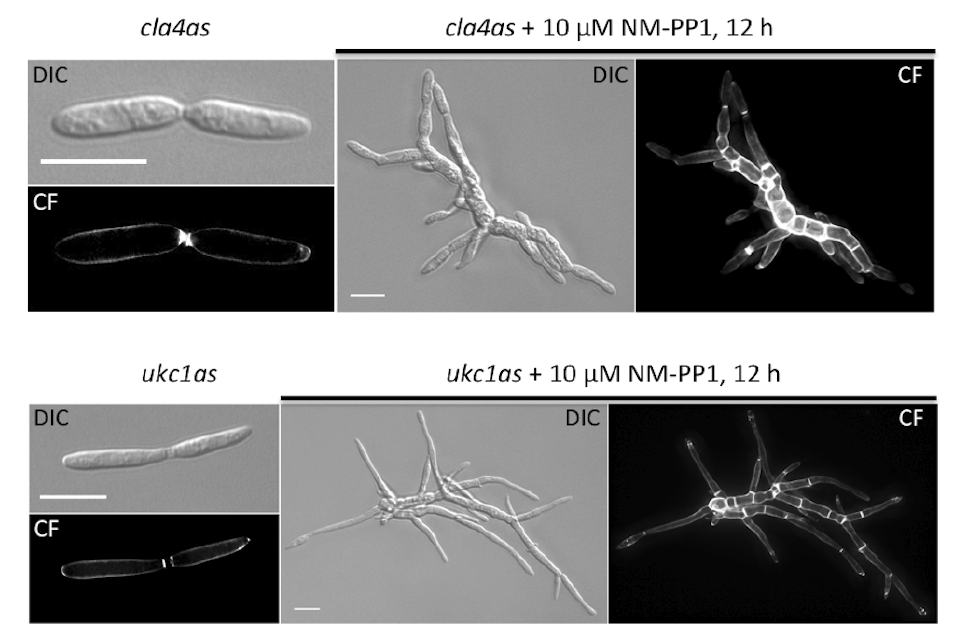
Figure 2. Inhibition of Cla4as and Ukc1as using NM-PP1. Cells expressing cla4as of ukc1as were grown to an OD = 0.1 and split in media with or without inhibitor. After 600 further growth for 12 h cells were stained with Calcofluor white (CF). The respective brightfield images are shown (DIC). (Scale bars: 10